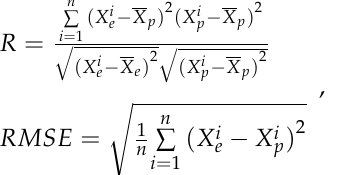
The obtained DRX model and the experimental result are described in Figure 12. Fig- ure 12a–c, respectively, show the experimental result and the calculated model of the DRX volume fraction of Cr8 alloy steel. The model curve agreed well with the experimental results. Figure 12d depicts the correlation study of the experimental value and the calcu- lated value of the DRX volume fraction. The correlation coefficient R = 0.988 and the root mean square error RMSE = 0.053 were obtained by